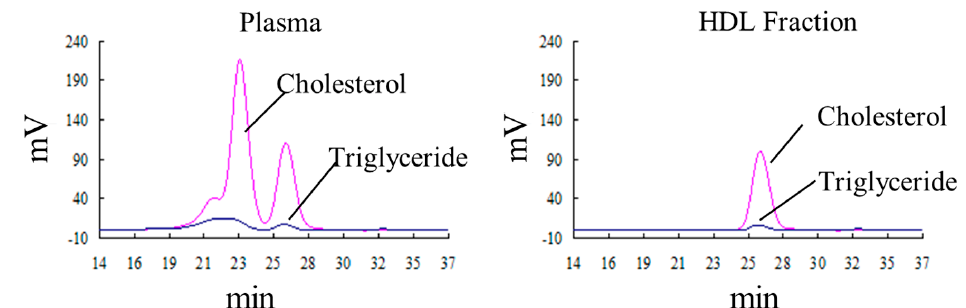
Figure 3. The lipoprotein analyses of plasma and high-density lipoprotein (HDL) fraction by gel-permeation high-performance liquid chromatography (GP-HPLC). The HDL fraction was isolated from the plasma of a healthy subject by using the dextran sulfate/Mg 2+ method as described in the Section 4. The plasma and isolated HDL fractions were analyzed by using a dual detection GP-HPLC system for lipoprotein analysis as described in the Section 4. Cholesterol and triglycerides concentrations were monitored for lipoprotein profiling. The retention times of the low-density lipoprotein (LDL) and HDL standard materials were 23.2 and 26.0 min, respectively. Table 1. Cholesterol concentrations of the major classes and subclasses of lipoproteins in plasma and HDL fractions.